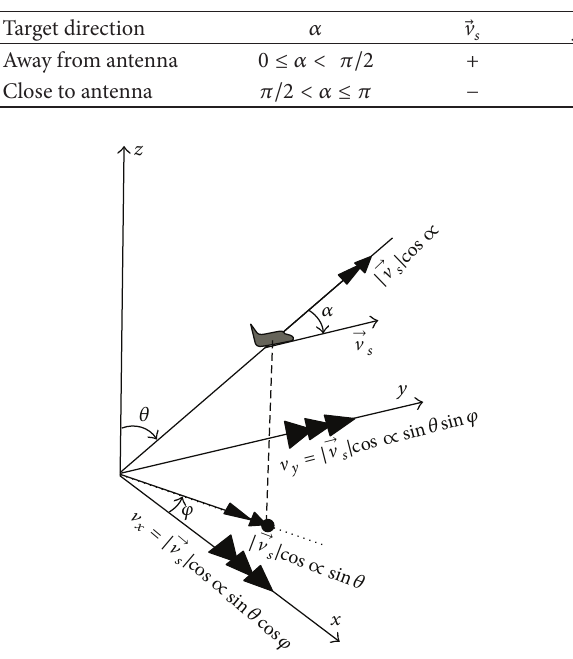
Table 1: Relation between target direction and Doppler sign.